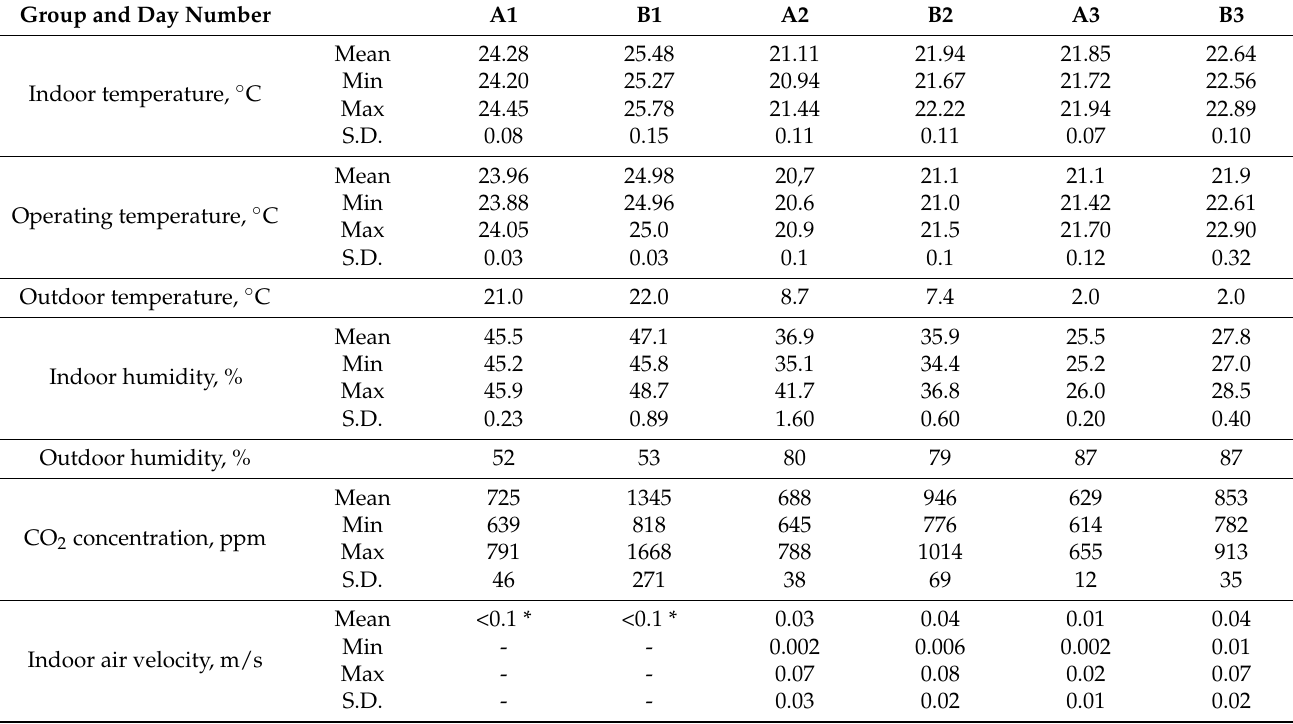
Table 4. Summary of measured and surveyed